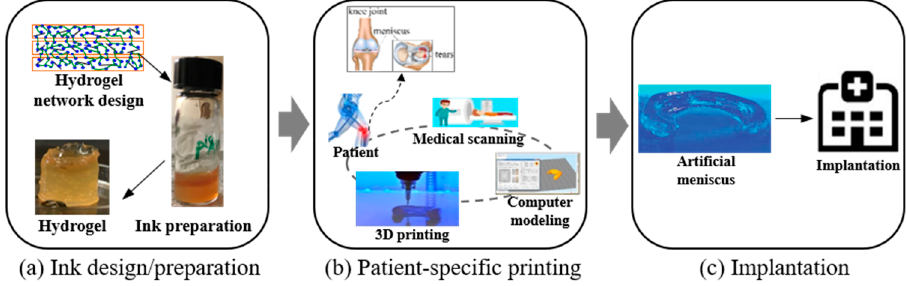
Figure 1. Roadmap for 3D printing of an artificial meniscus and meniscus implantation.